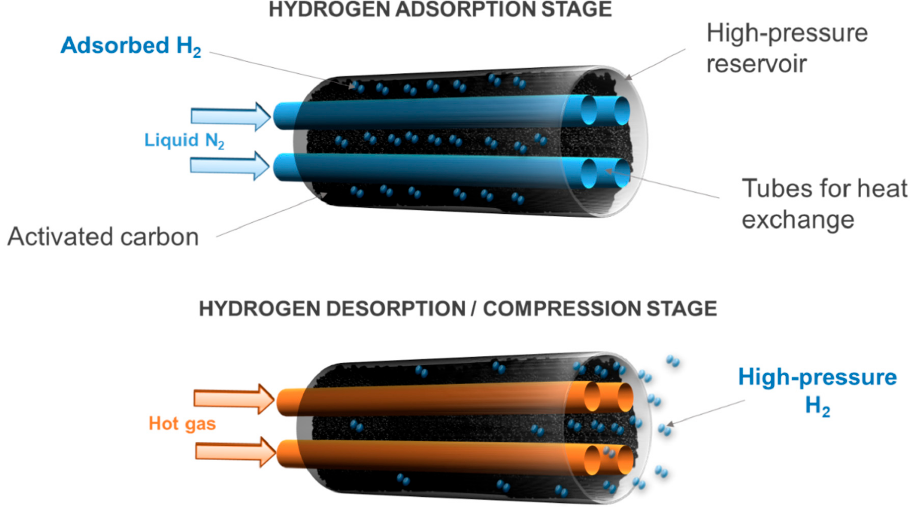
Figure 7. Operating principles of an adsorption–desorption compressor.